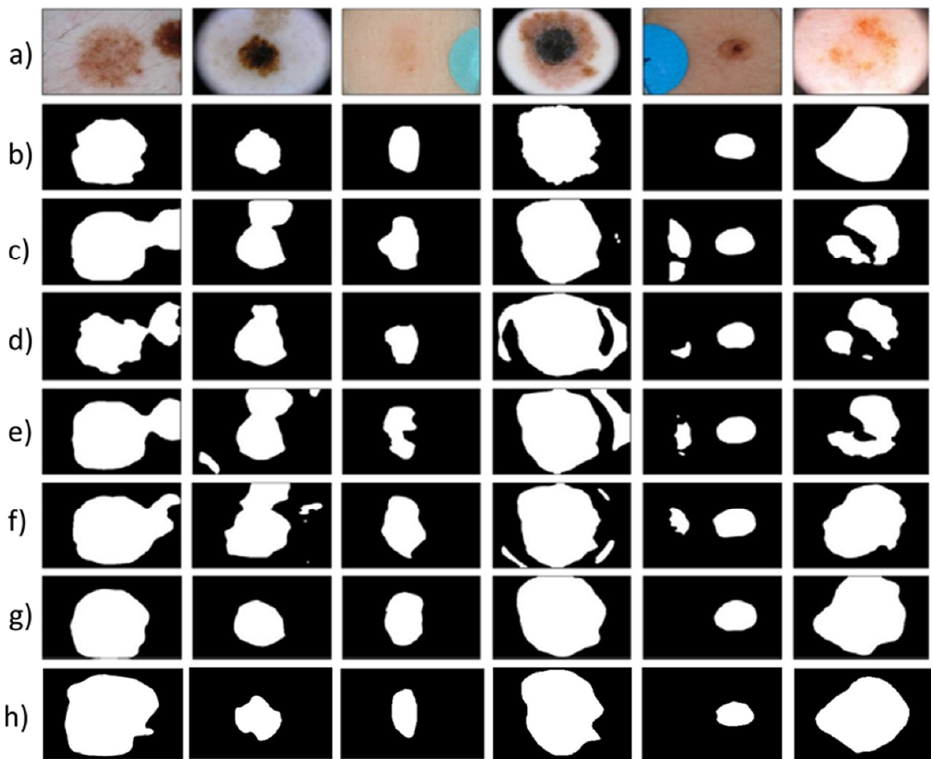
Figure 11. ( a ) Original input image, ( b ) ground truth images, ( c ) segmentation results of simple U-Net, ( d ) segmentation results of SE block on basic U-Net, ( e ) segmentation results of the BCDU network (with 1 dense unit), ( f ) segmentation results of the U-Net network (with all 64 filters), and ( g ) segmentation results of Att U-Net + GN + TL. ( h ) Results of our RL algorithm. As can be seen from the image, the results of the masks are clear. Our algorithm is able to segment the lesions with a high Acc . The other statistical measures are also higher than the other methods.